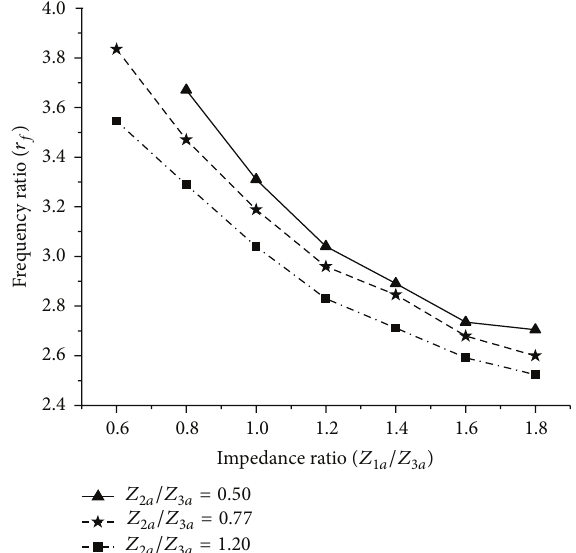
Figure 4: Variation of the frequency ratio ( 𝑟 𝑓 ) versus varied impedance ratios for the proposed TSSIR 𝑎 .